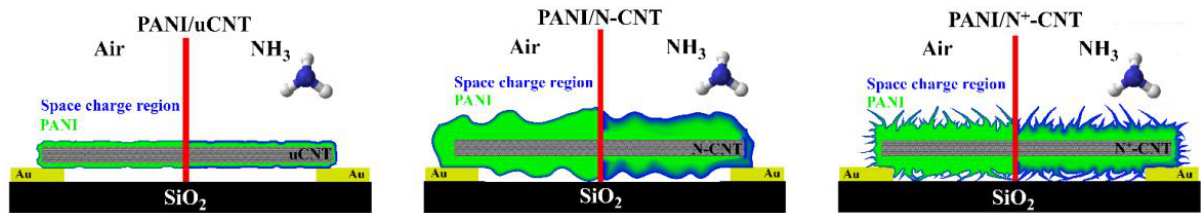
Figure 7. Schematic of changes if the SCR of PANI/uCNT, PANI/N-CNT and PANI/N + -CNT composites during ammonia adsorption.